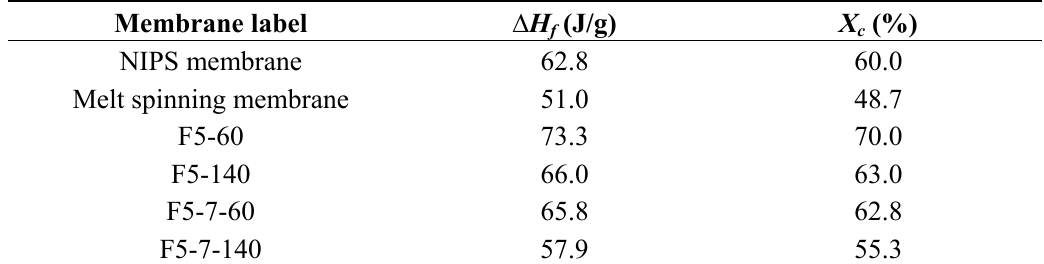
Table 3. Heat of fusion ( ∆ H preparation